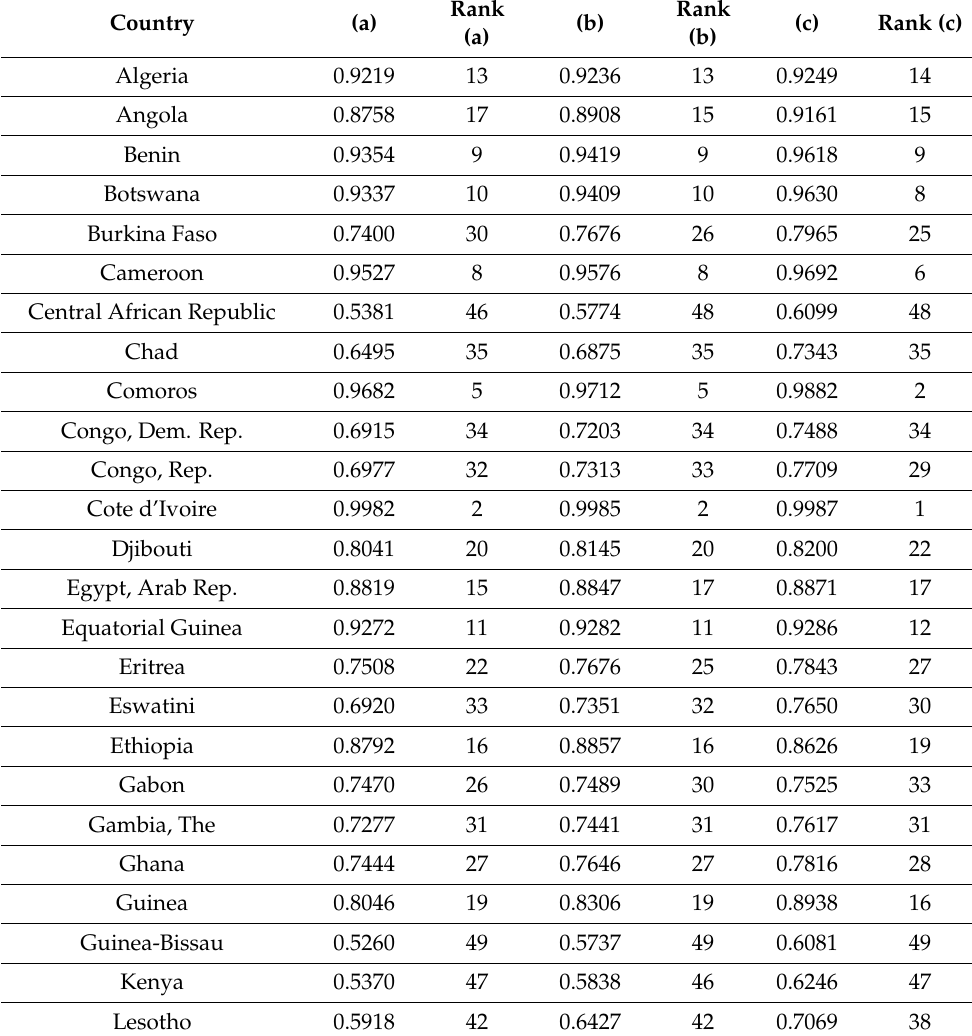
Table 11. Cumulative results for the index of access to electricity—HDI. Source: own calculations.